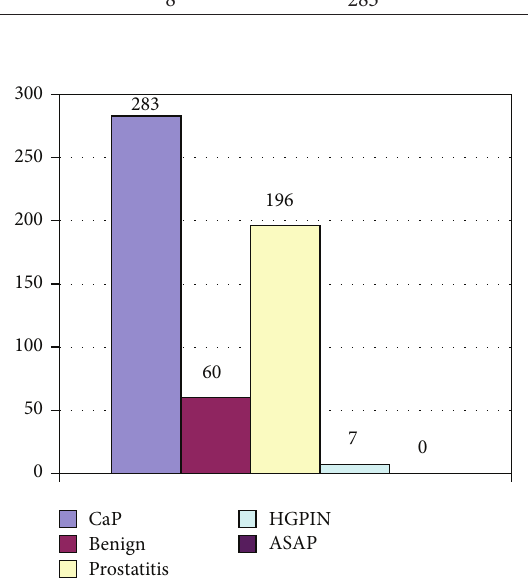
Figure 1: Distribution of the patients by histological diagnosis, 𝑛 = 546 .